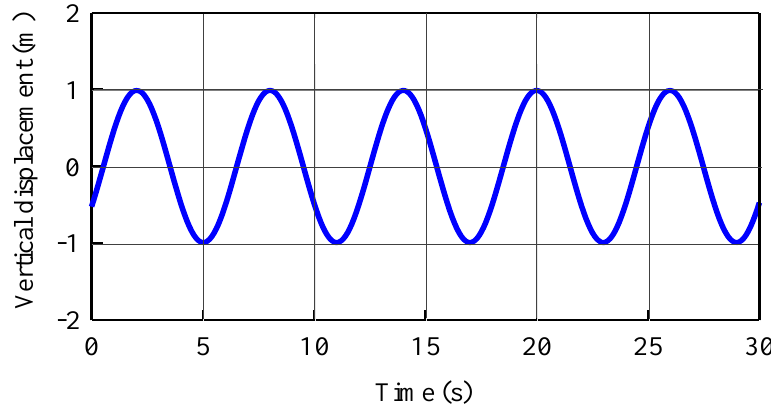
Figure 6. Inverse vertical displacement time series (T = 6 s).